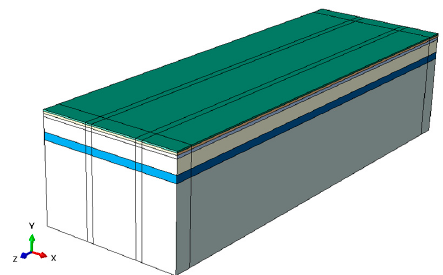
Figure 4. Pavement Figure 4. Pavement structure.